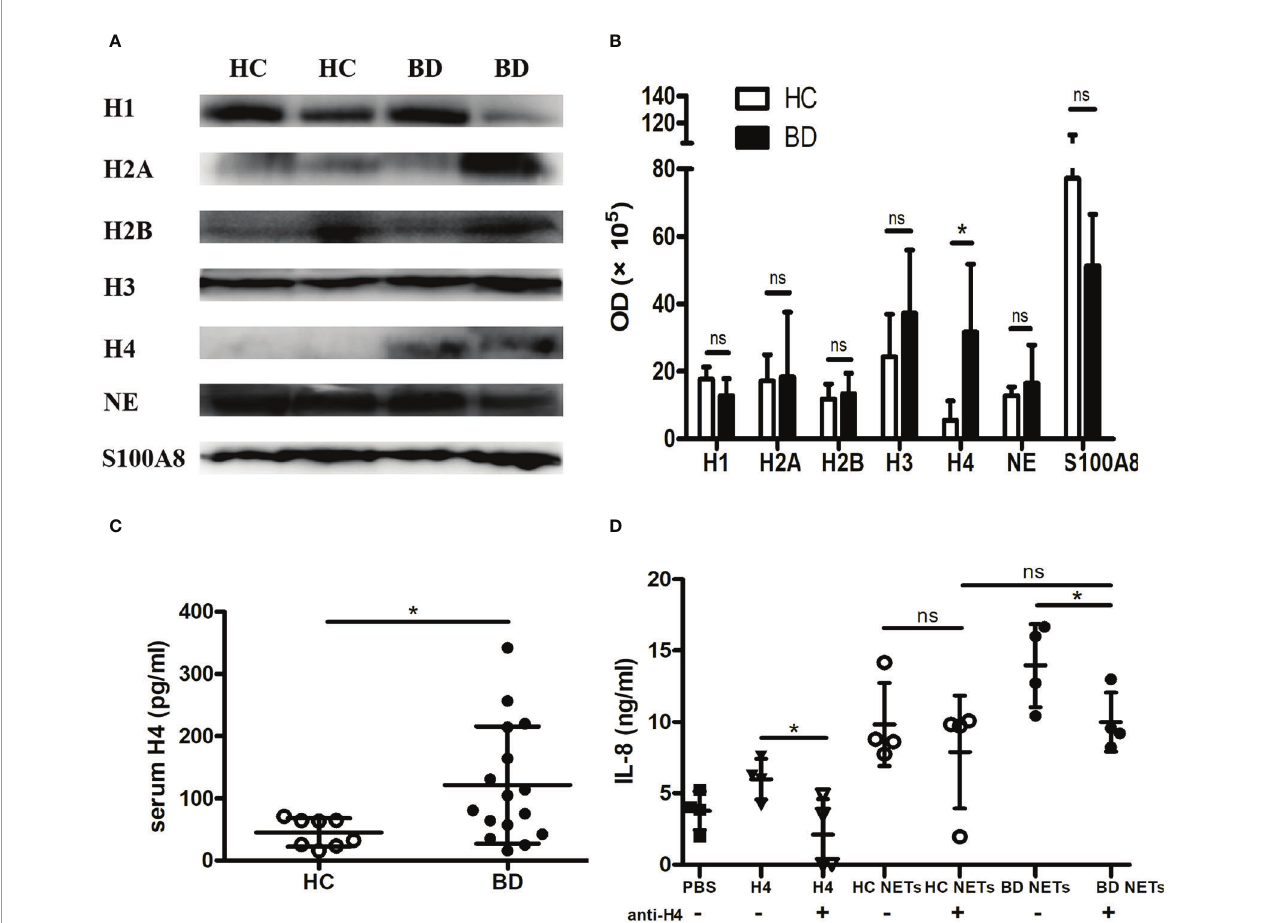
FIGURE 3 | Histone H4 in BD neutrophil extracellular traps (NETs) promotes macrophages activation. (A) Representative images and (B) summary of western blot of Histone H1, Histone H2A, Histone H2B, Histone H3, Histone H4, NE, and S100A8 in HC NETs (n = 4) and BD NETs (n = 4). (C) Serum Histone H4 from HC (n = 8) and BD (n = 16) were measured by ELISA. (D) HC NETs (n = 4) or BD NETs (n = 4) were pretreated with anti-Histone H4 antibody, and stimulated macrophages for 24 h. IL-8 production was measured using ELISA. Bars indicate mean value and Standard Deviation. Mann-Whitney U test (B-C), paired t-test (D) and Student ’ s t-test (D) were applied. *p < 0.05. BD, Behc ̧ et ’ s disease; HC healthy controls; ns, not signi fi